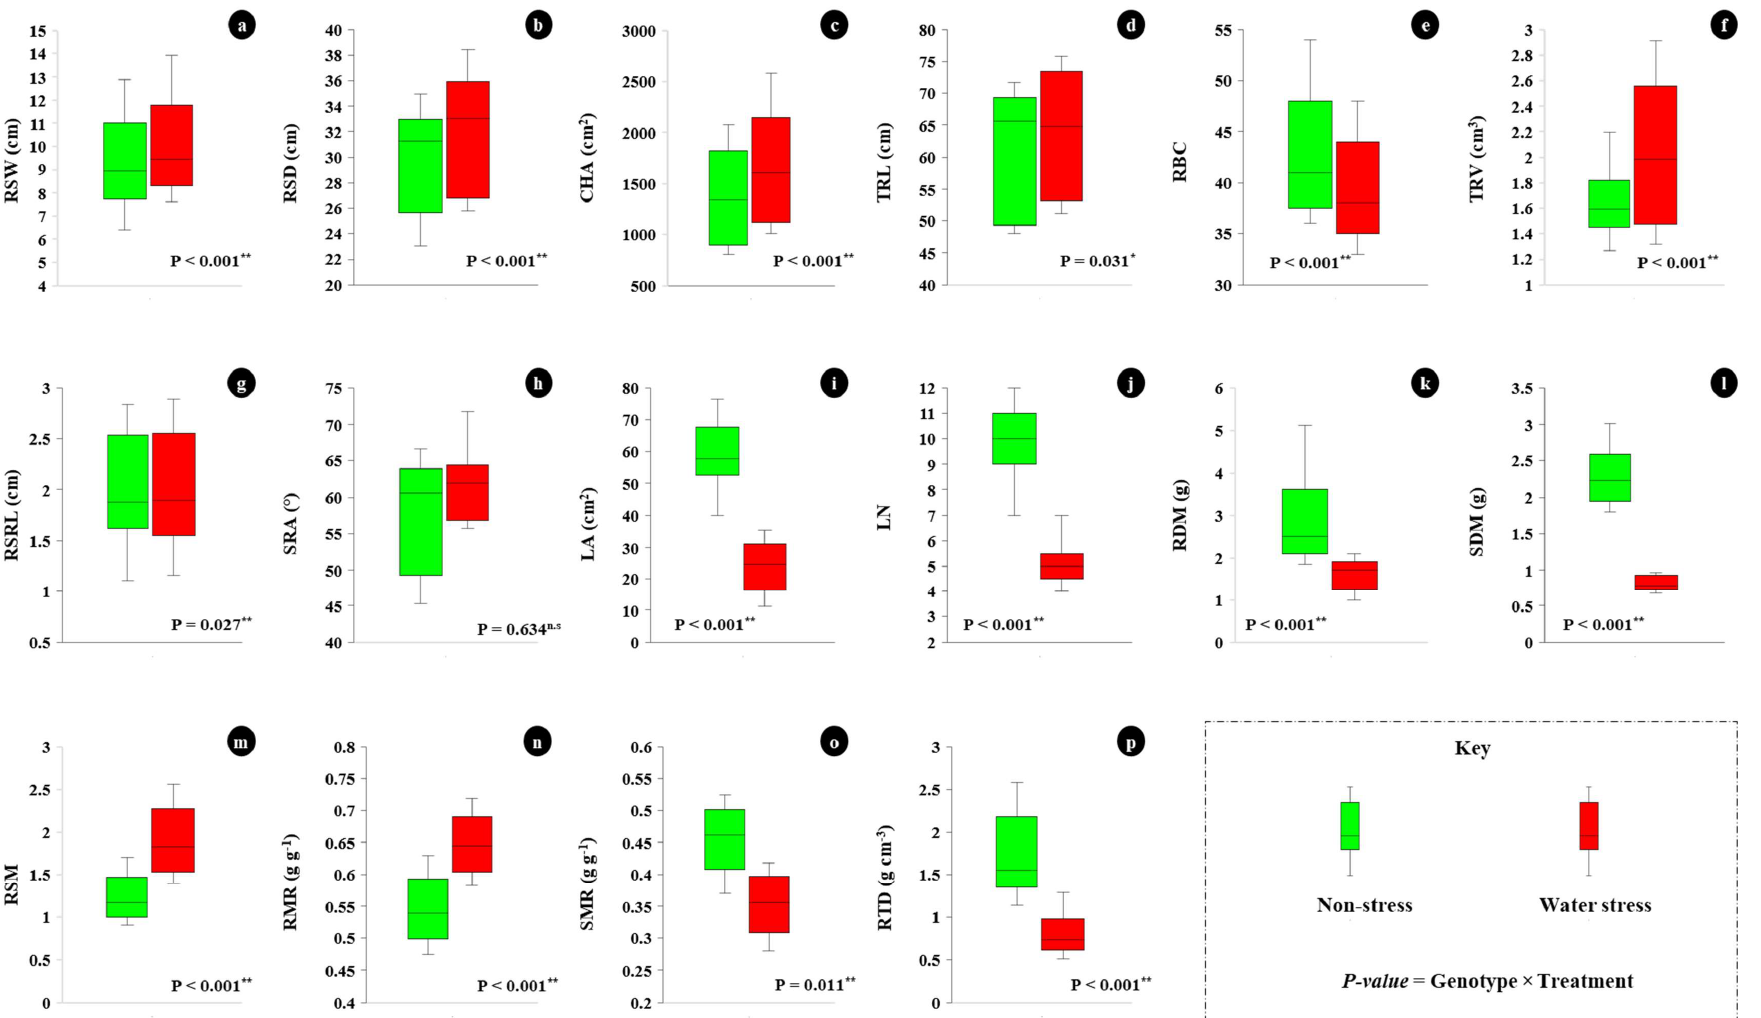
Figure 4 : Summarized effect of non-water stress and water stress at 35 DAP: ( a ) root system width, ( b ) root system depth, ( c ) convex hull area, ( d ) total root length, ( e ) root branch count, ( f ) total root volume, ( g ) first seminal root length, ( h ) seminal root angle, ( i ) leaf area, ( j ) leaf number, ( k ) root dry mass, ( l ) shoot dry mass, ( m ) root shoot mass ratio, ( n ) root mass ratio, ( o ) shoot mass ratio, ( p ) root tissue density. ns ; non-significant. * and ** denote significance at 5% and 1% probability